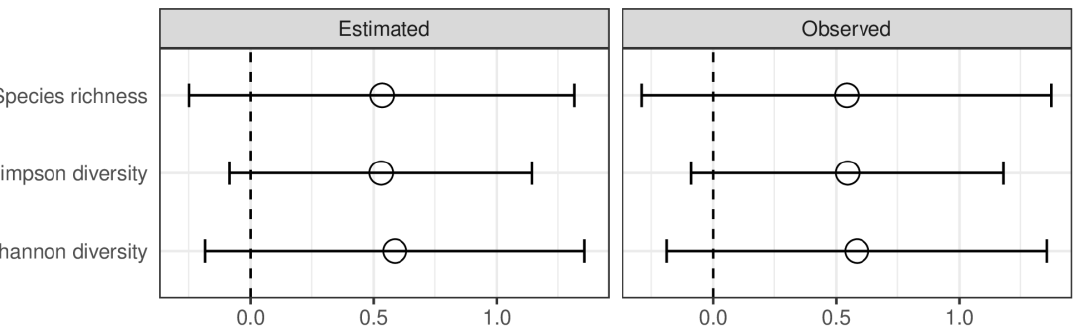
Figure 2. Observed and estimated alpha diversity for comparison between patients with alcohol use disorder and healthy controls denoted as Agresti’s generalized odds ratio and summarized with random effects model; values greater than 0 indicate greater richness in healthy controls. An open dot denotes statistically insignificant results. Error bars indicate 95% confidence intervals.